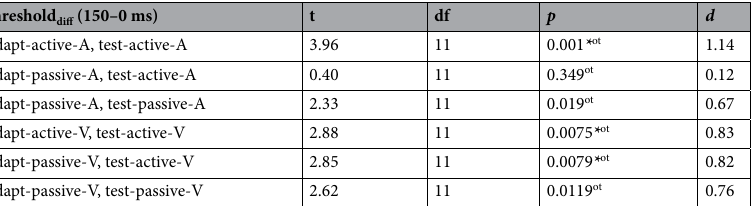
Table 3. One sample t-test results on threshold differences (threshold Diff ) between 150 and 0 ms adaptation delays, indication recalibration within modalities. Bold asterisks indicate significant effects. ‘ ot ’ indicate one-tailed test values. t, value; df, degrees of freedom; d , Cohen’s d . All tests were corrected for multiple comparisons.